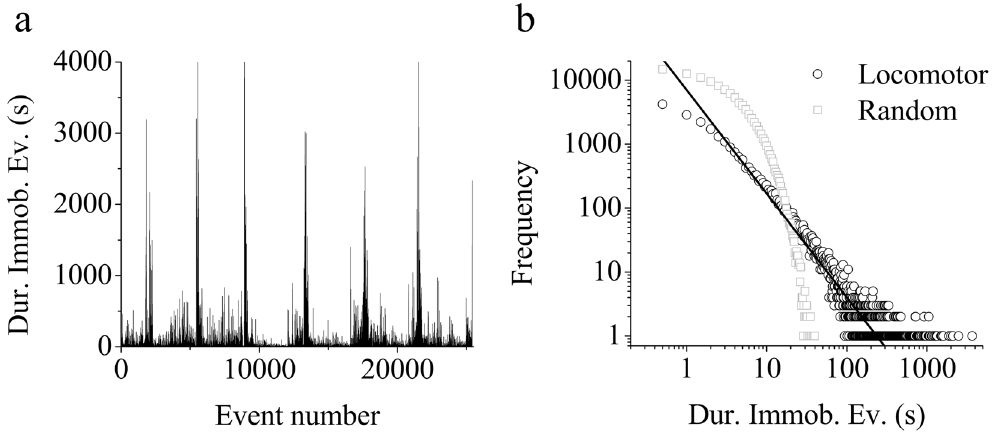
Figure 8. Power-law (fractal) distribution of the duration of immobility events. ( a ) Immobility event duration as a function of the event number for the same animal time series represented in Fig. 6. ( b ) Frequency distribution of the immobility events computed from the 6.5 days of continuous recording (black open circles). Solid line corresponds to the linear fit in the log-log plot, y = − 1.62x + 3.85 (r 2 = 0.91), estimated for event sizes from 1 to 250 s (see Supplementary Figure for 13 for details on criteria for selecting scaling region), indicating fractal behavior according to an inverse power law. The same time series was randomized and then reanalyzed (grey open squares) for comparison. Random data fits an exponential distribution (r 2 = 0.86). Complete high- resolution time series (10 6 data points) were used for event duration